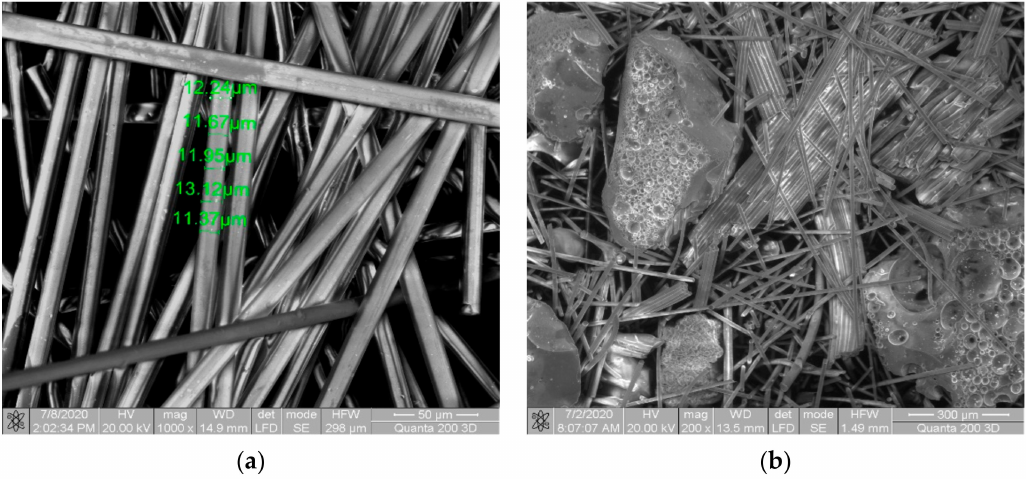
Figure 2. SEM analysis for ( a ) fiberglass waste; ( b ) fiberglass waste treated with hydrogen plasma. EDX analysis indicated the presence of a silicon (Si) peak at 1.9 keV for both fiberglass